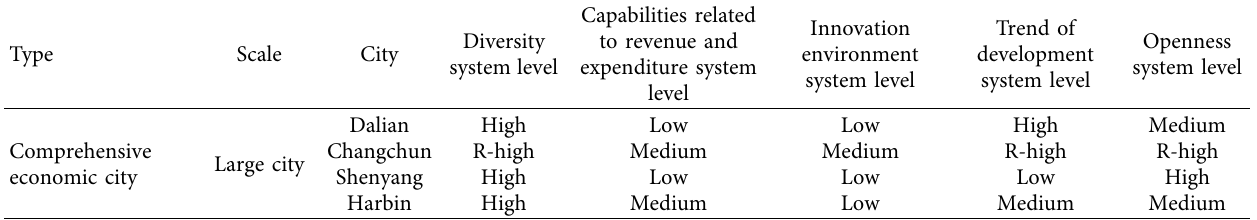
Figure 3: Spatial distribution of the degree of contribution of subsystems on urban economic resilience. (a) Contribution degree of the diversity system. (b) Contribution degree of capabilities related to revenue and expenditure system. (c) Contribution degree of the in- novation environment system. (d) Contribution degree of the trend development system. (e) Contribution degree of the openness system. Table 4: Weight ratings of subsystems contributing economic resilience for different types and scales of